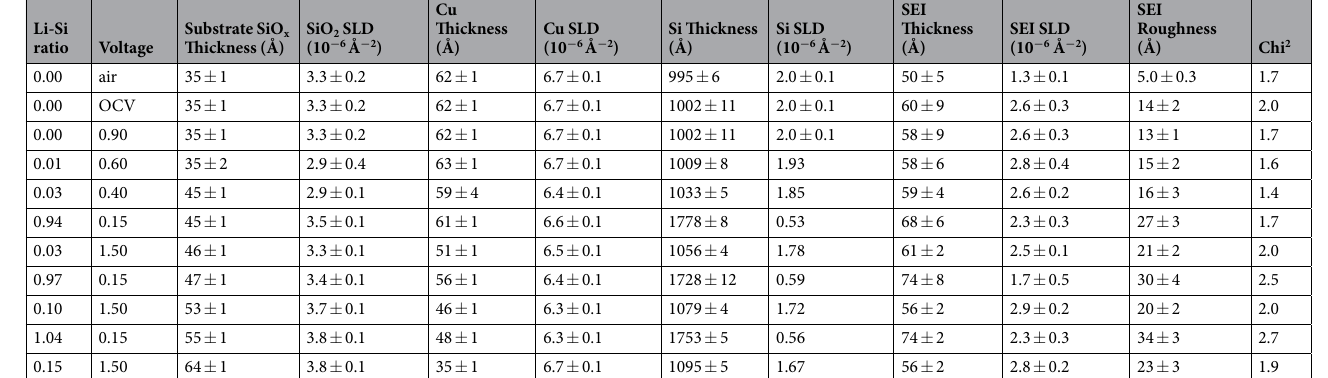
Table 1. Refined thicknesses and SLD values for the sample measured in this study. Si SLD values without errors were constrained using the fitted thickness while those with errors were left to vary in the fit. The values in the SEI columns for the air fit are actually the oxide layer on top of the a-Si.